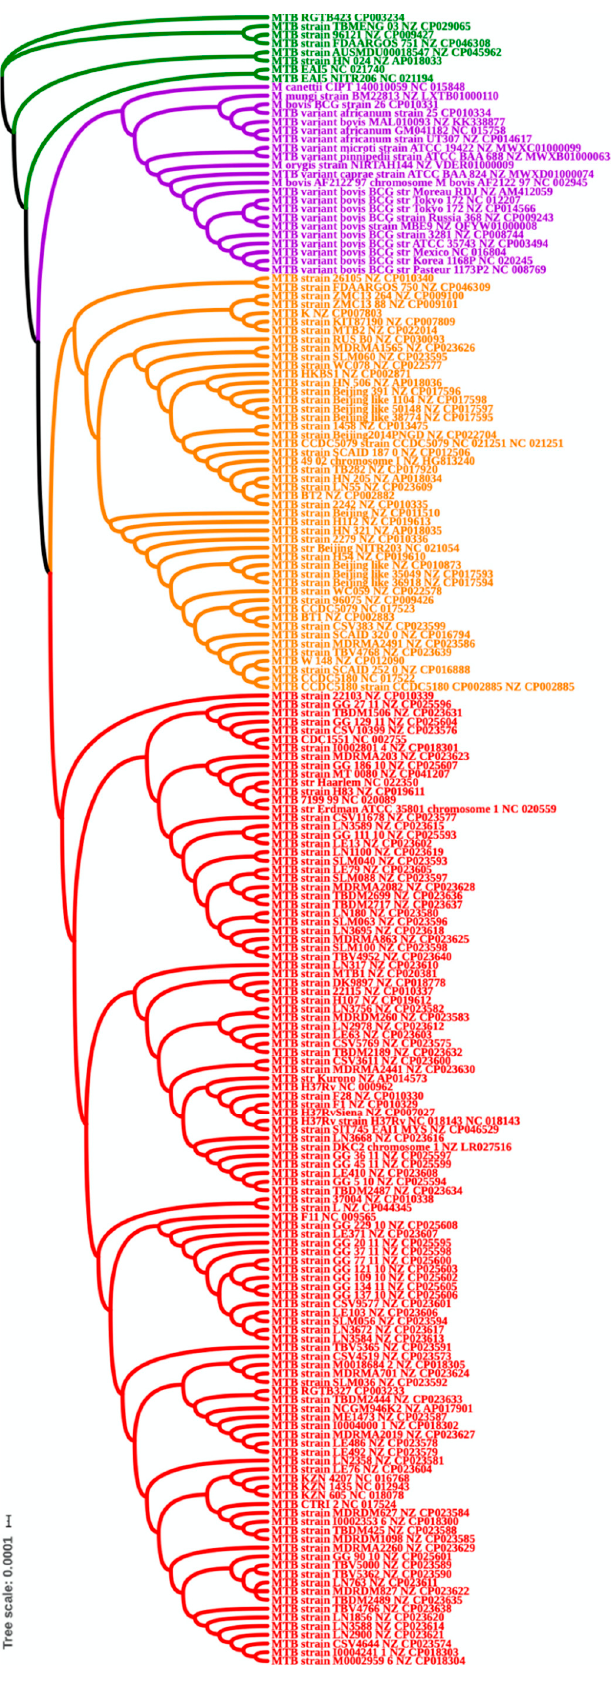
Figure 2. Phylogenetic tree based on core genome.